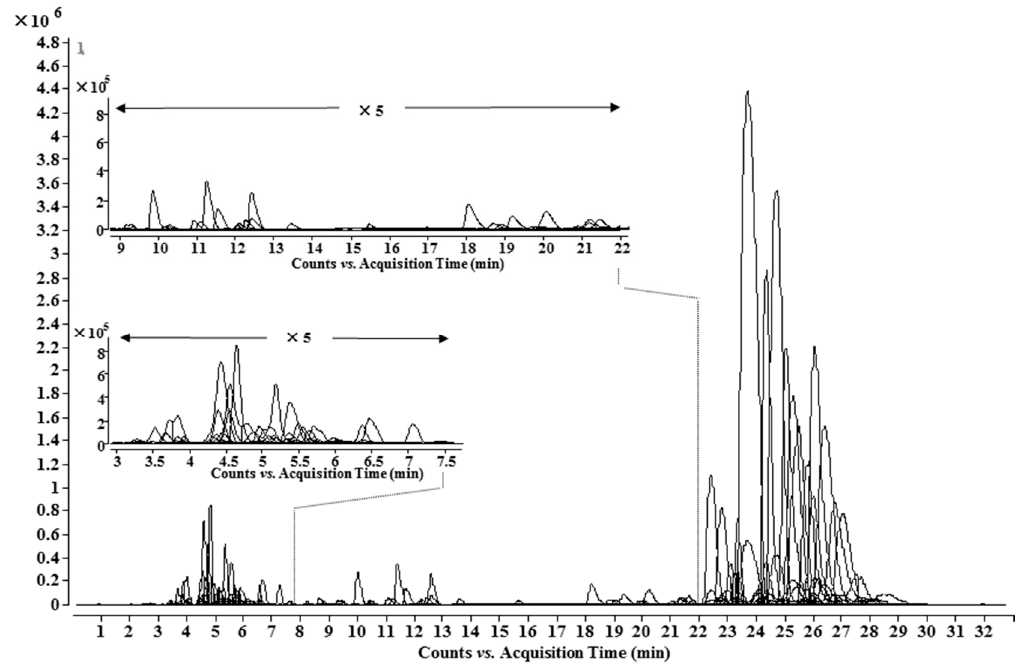
Figure 4. UHPLC-MS chromatogram of the identified lipo-alkaloids in A. carmichaelii .